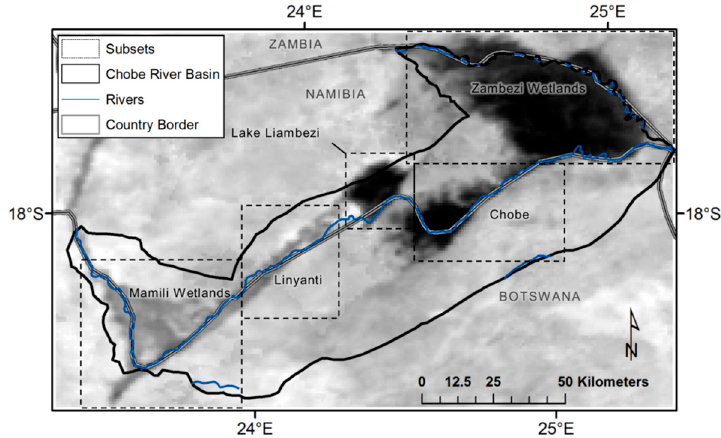
Figure 5. Subsets of the Chobe River Basin used in regression analysis.